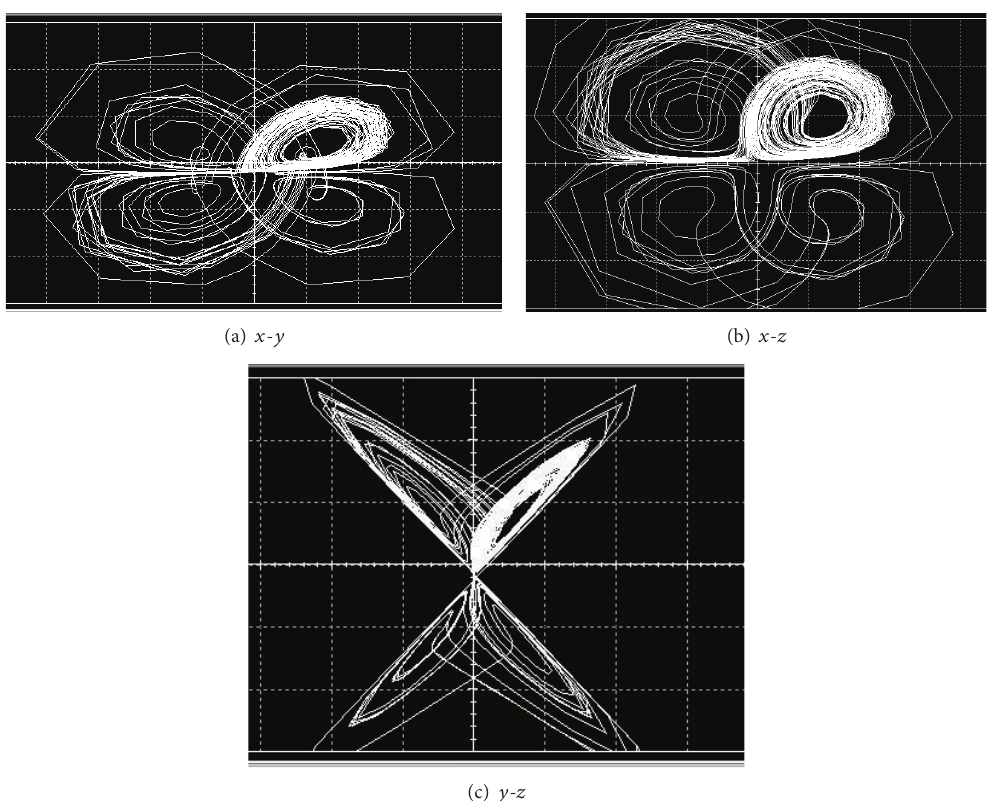
Figure 7: Circuit simulation results of the new wing doubled fractional-order chaotic system